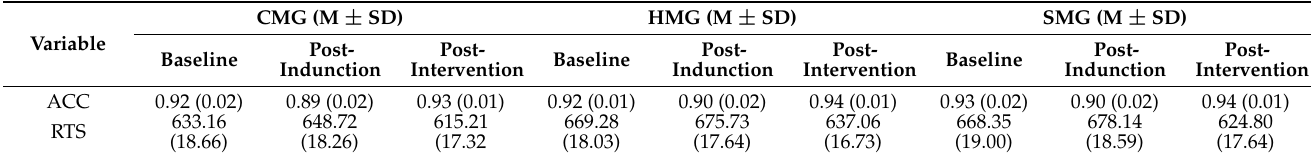
Table 2. Descriptive statistics of emotional Stroop task.